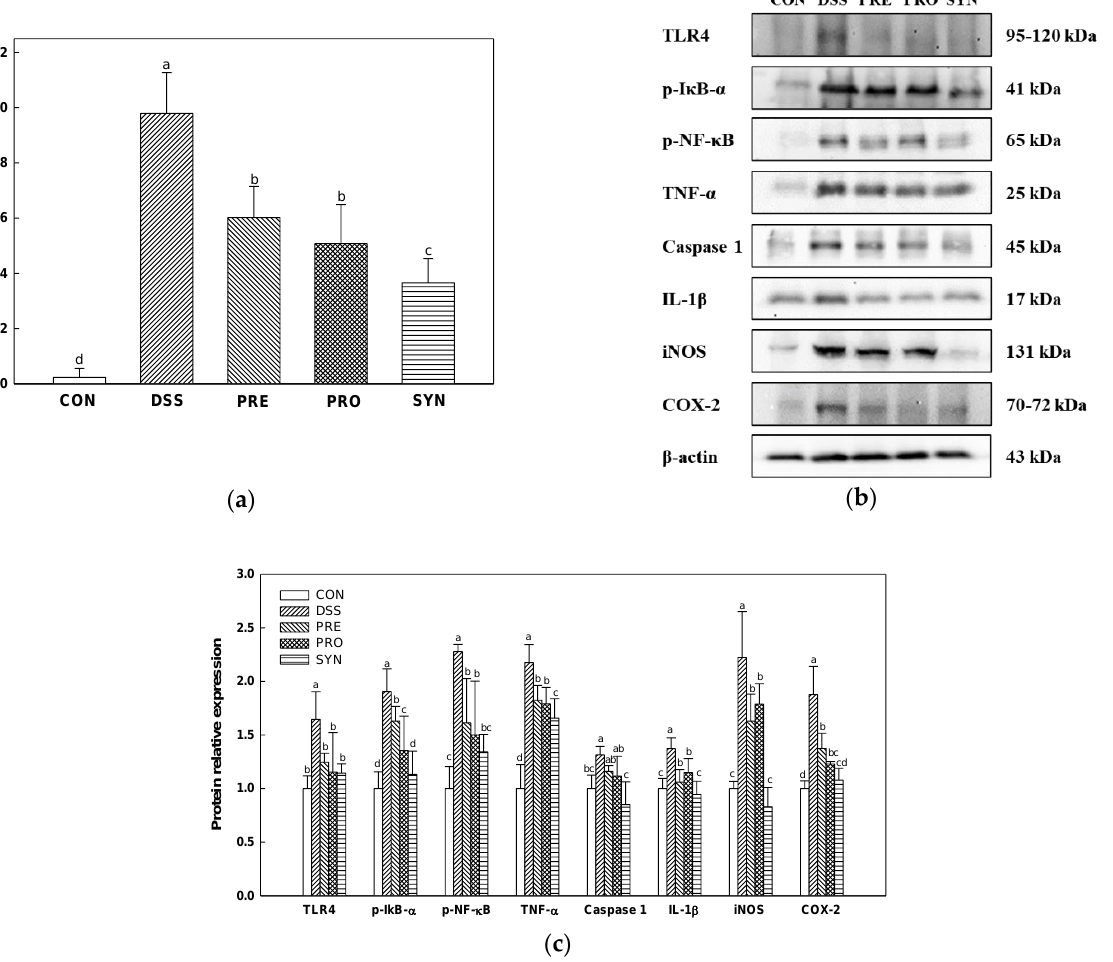
Figure 3. Effects of PRE, PRO, and SYN on inflammatory responses in colon tissues of DSS-induced colitis mice. Myeloperoxidase (MPO) activity ( a ), Western blot band images ( b ), and the expression levels of TLR4, p-I κ B- α , p-NF- κ B, TNF- α , caspase 1, IL-1 β , iNOS, and COX-2 ( c ). The results were presented as the mean ± SD (MPO activity; n = 5, Western blot; n = 3). Data were statistically considered at p < 0.05, and different lowercase letters indicate significant differences between groups.